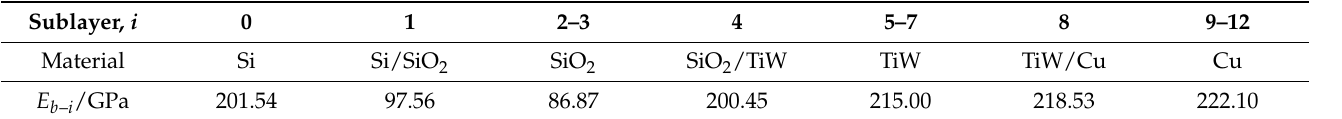
Table 4. Samples after annealing.